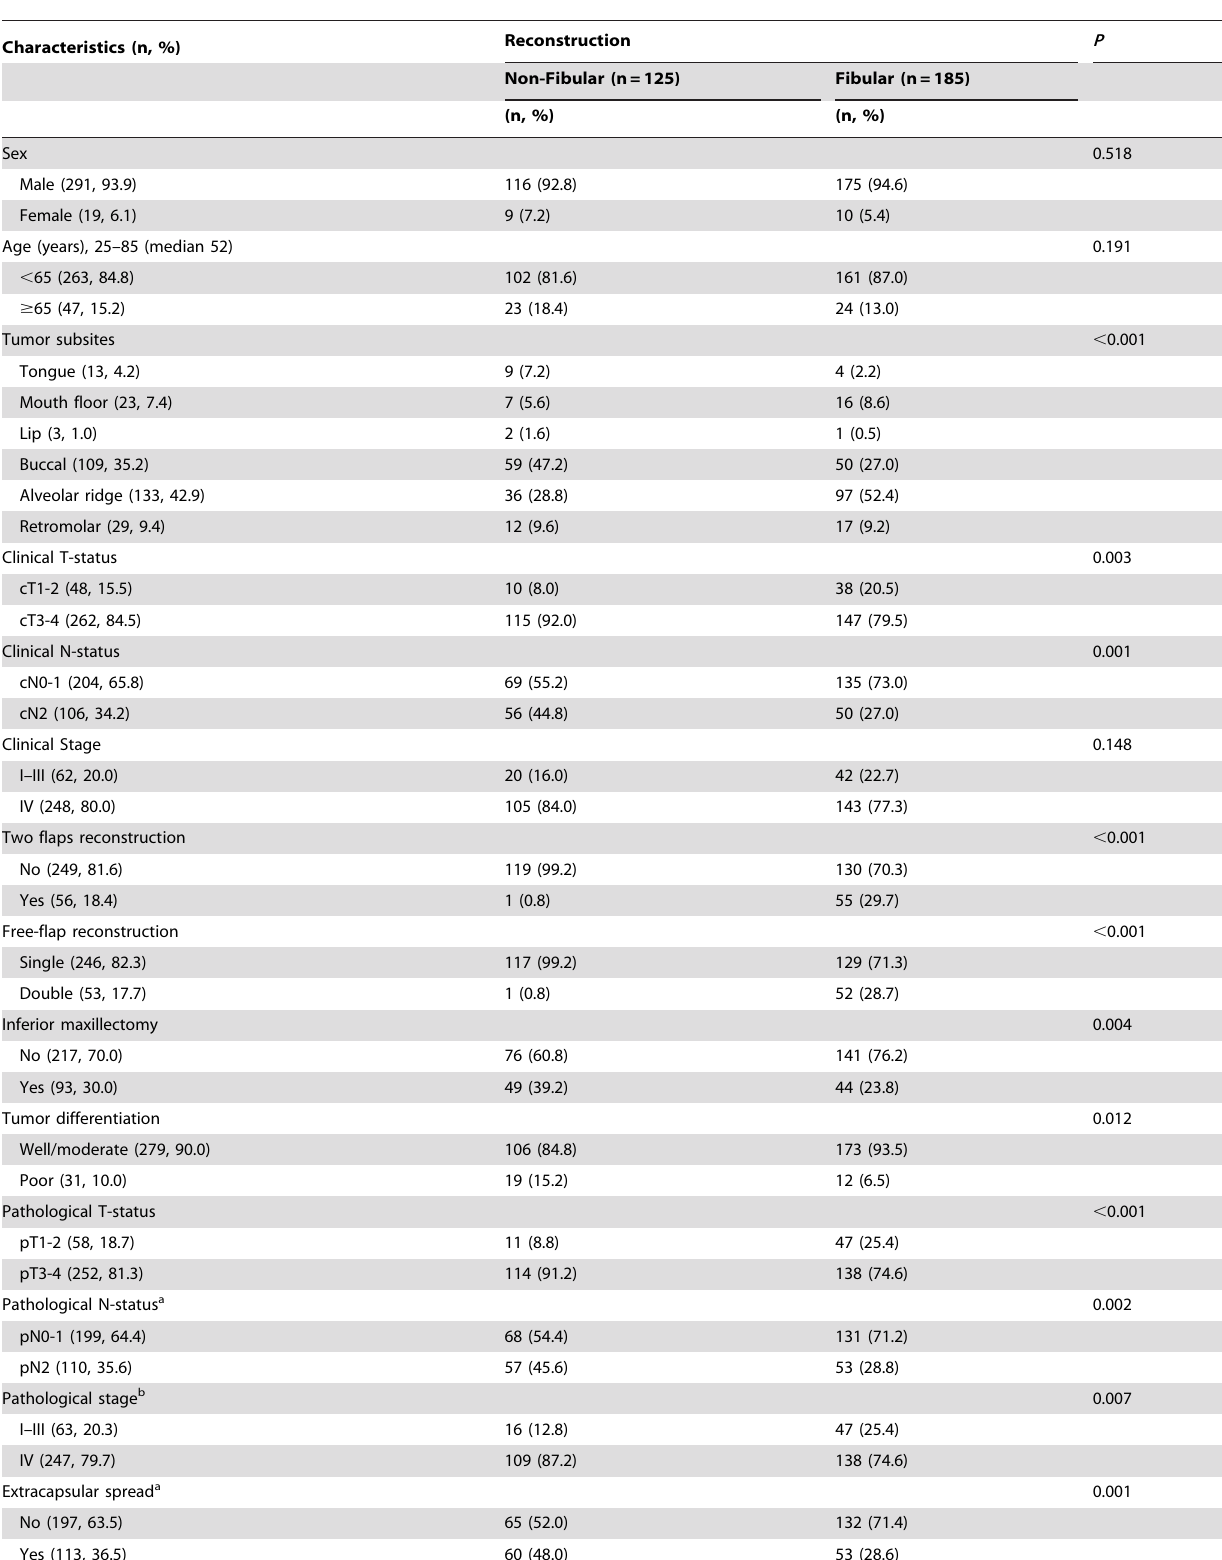
Table 1. The clinicopathological characteristics of OSCC patients treated by segmental mandibulectomy.